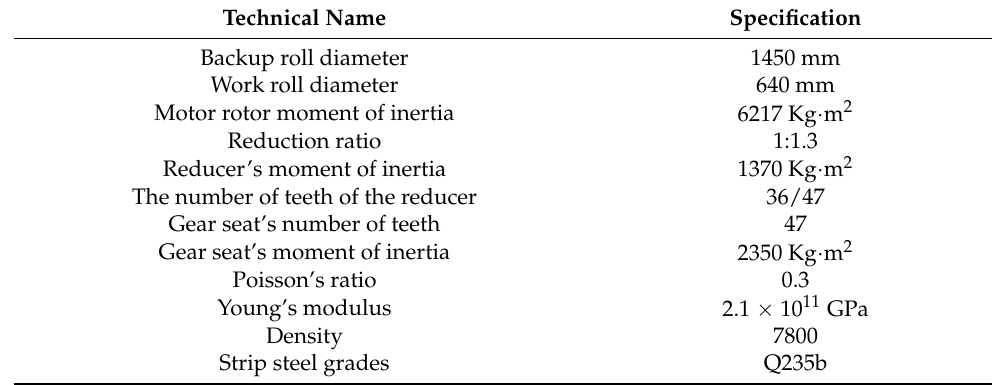
Figure 2. Three-dimensional geometry of the F3 rolling mill: 1—motor; 2—gear coupling; 3—gearbox gear; 4—gear seat gear; 5—gear spindle; 6—strip; 7—mill stand; 8—backup roll; 9—work roll; 10—crossbeam. Table 1. Main parameters of F3 frame.